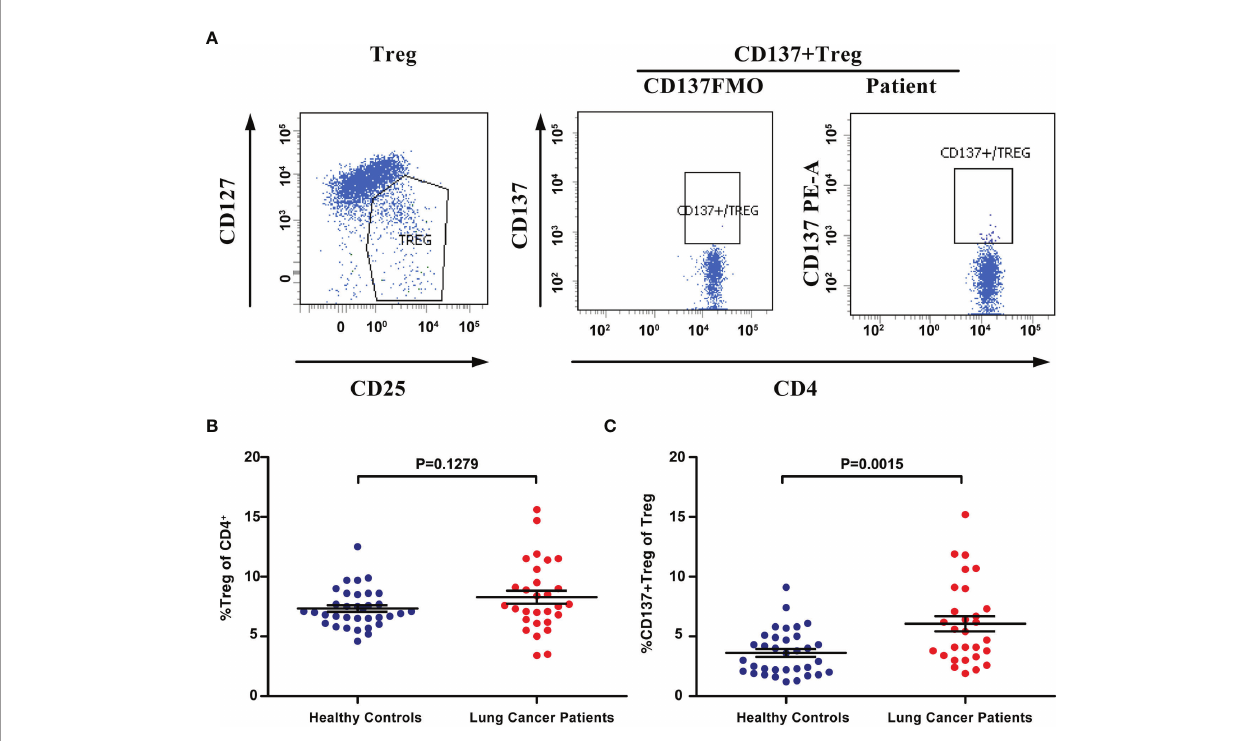
FIGURE 3 | The percentage of CD137+ Tregs was increased in the blood of lung cancer patients. (A) Tregs and CD137+ Tregs were gated by fl ow cytometry. (B) The percentage of Tregs in lung cancer patients (n=29) and healthy controls (n=34). (C) The percentage of CD137+ Tregs in the same patients and healthy controls. Differences are indicated as P values. The error bars represent the